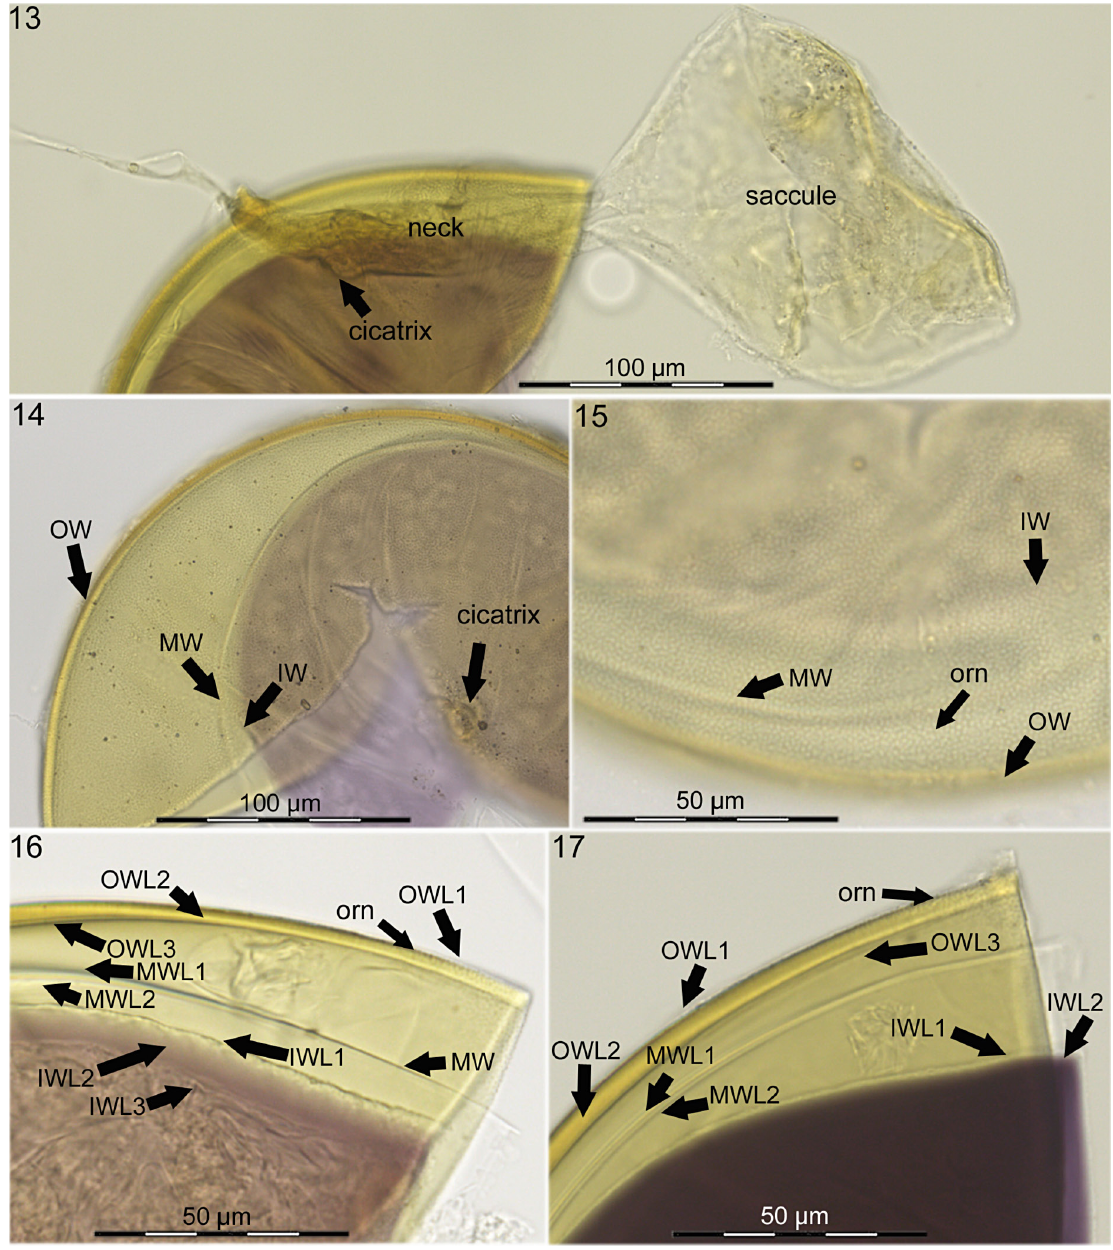
Figs. 13-17 Acaulospora aspera : 13. Crushed spore formed laterally on a collapsing sporiferous saccule. 14. Crushed spore stained in Melzer’s reagent and showing three walls: OW, MW & IW. Spore surface ornamentation, and also the spore base visible, leaving a permanent cicatrix. 15. The asper, ‘washboard-like’ ornamentation (orn) on the outer surface of the pigmented, structural spore wall layer, in planar view. 16-17. Segments of crushed spores with triple layered OW (OWL1-3), bi-layered MW (MWL1-2) and triple layered IW (IWL1-3), in cross view. The washboard-like ornamentation is on the surface of the pigmented, structural layer (OWL2), thus a persistent structure, and consists of innumerous small and shallow pits. IWL1 with beaded wall, as typical for Acaulosporaceae species; IWL2 staining purple to dark purple, when exposed to Melzer’s